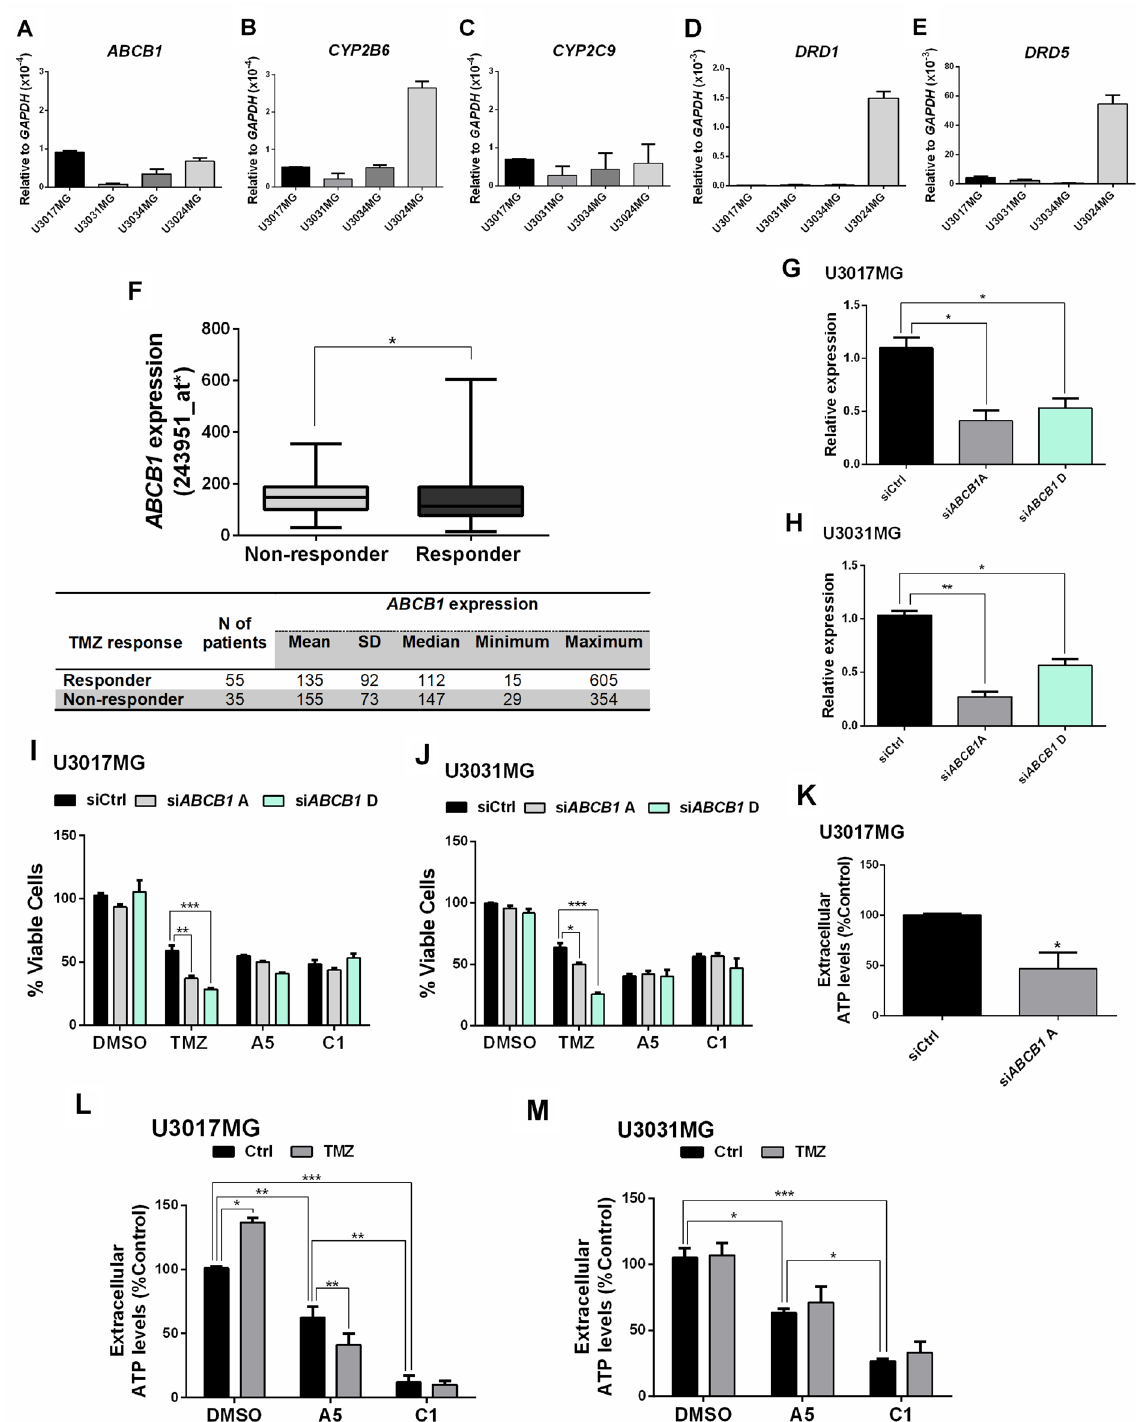
Figure 5. Characterization of predicted targets for aporphine and isoquinoline derivatives. RT-qPCR was used for detection of ( A ) ABCB1 , ( B ) CYP2B6 , ( C ) CYP2C9 , ( D ) DRD1 and ( E ) DRD5 mRNA levels in U3017MG, U3031MG, U3034MG and U3024MG cells. ( F ) Correlation of TMZ response with ABCB1 expression in tumor samples of GBM patients retrieved from http:// www. rocpl ot. org/ gbm. Asterisk on probe number indicates measurement by Affymetrix U133plus. GBM patients were categorized according to TMZ response and comparisons were performed with Mann–Whitney U-test ( p = 0.0492). ( G , H ) RT-qPCR was used for detection of ABCB1 after siRNA transfection in U3017MG ( G ) or U3031MG ( H ) cells. All the relative expression levels were normalized to GAPDH expression, and calculated using the 2 −ΔCt method. Error bars represent SD from three different experiments. ( I , J ) Viability level of U3017MG ( I ) or U3031MG ( J ) cells after treatment for 48 h with APO (25 µM), A5 (30 µM) or C1 (30 µM) of cells transfected with control (siCtrl) or ABCB1 -specific siRNAs. Data were normalized against DMSO. ( K — M ) Extracellular ATP levels were measured in in U3017MG upon ABCB1 silencing ( K ) and in U3017MG ( L ) and U3031MG ( M ) cells after treatment with A5 (30 µM) or C1 (30 µM) in the presence or absence of TMZ (150 µM) for 48 h and. Error bars represent SD from at least two biological replicates. Asterisks denote significance as determined by Welch t test, one-way ANOVA multiple comparisons followed by Bonferroni or Dunnet test (post-test) when appropriate; * p < 0.01, ** p < 0.001, and *** p <